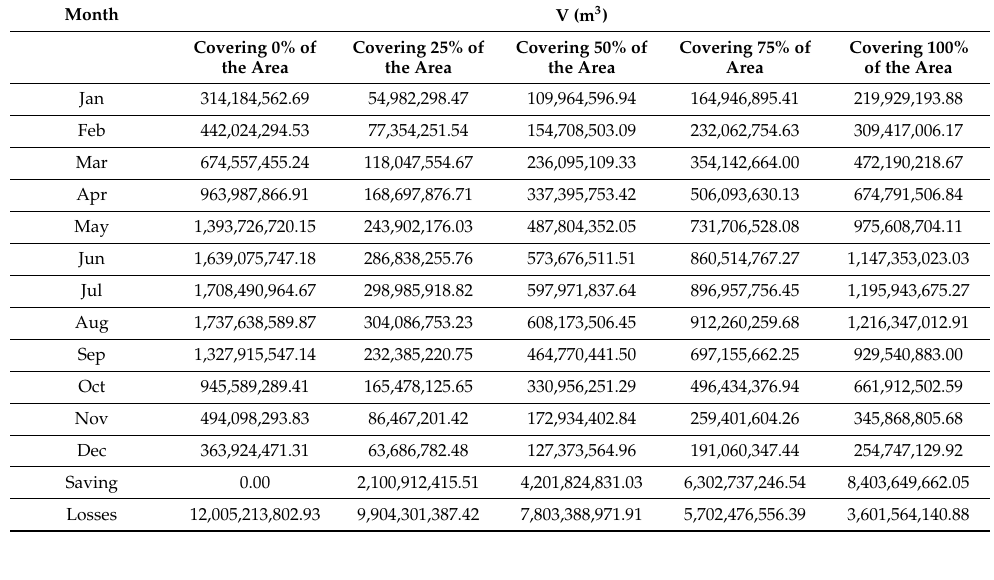
Table 5. Monthly water saving using a floating photovoltaic system (FPVS) at Lake Nasser.